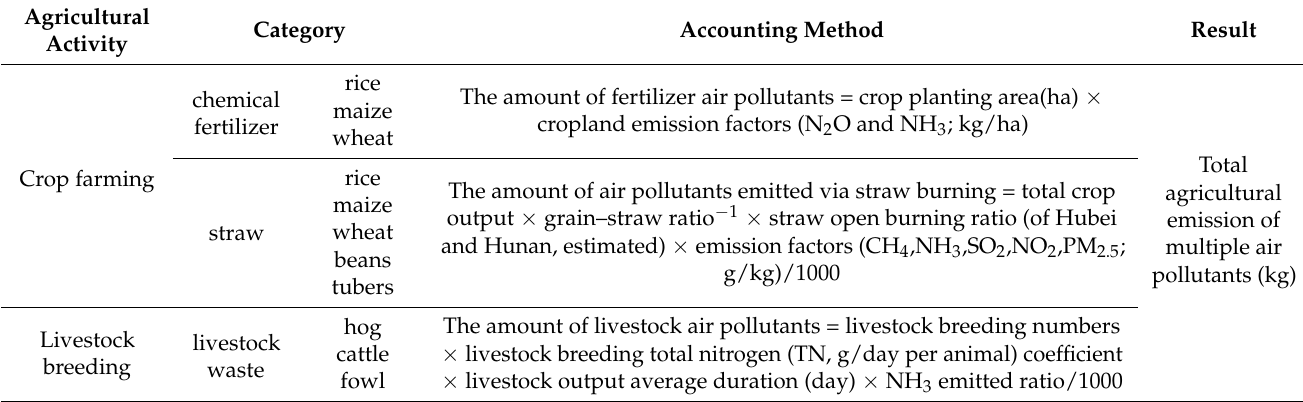
Table 2. Accounting method of pollution production